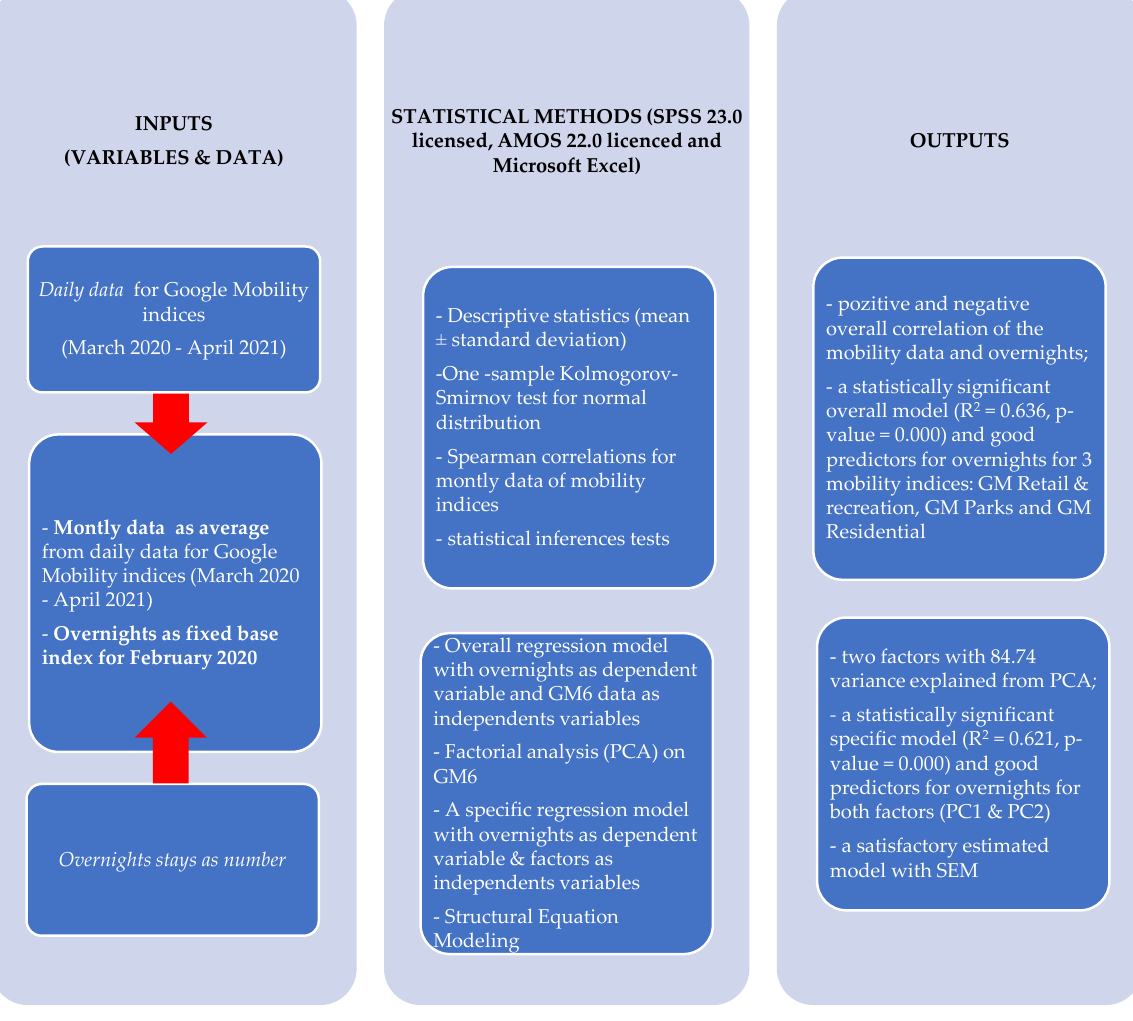
Figure 1. The research flowchart.